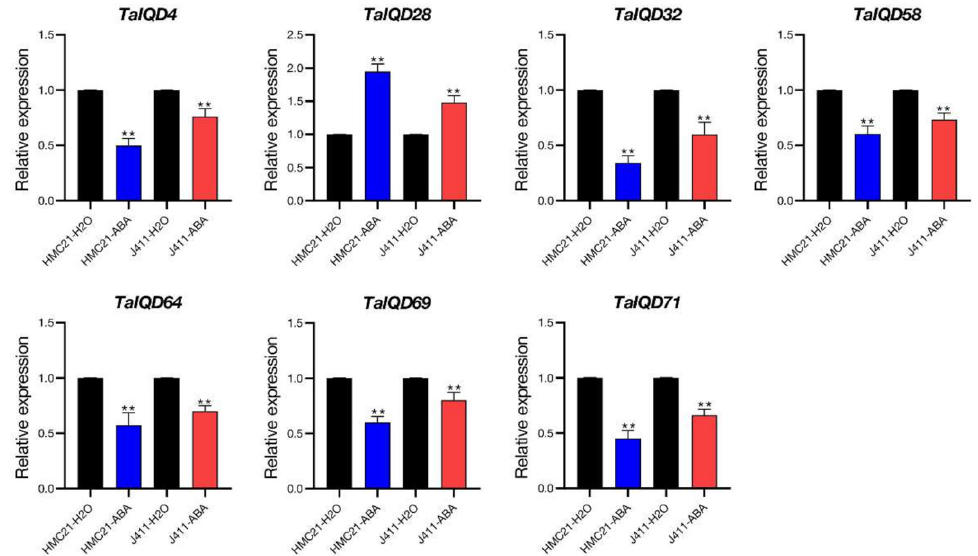
Figure 9. Expression patterns of seven TaIQD genes after 50- µ M ABA treatment in wheat varieties ‘Hongmangchun21’ (HMC21) and ‘Jing411’ (J411). Red indicates weak-dormancy varieties, and blue indicates strong-dormancy varieties. Y axes represent the scales of the relative expression levels. Bars represent the standard deviations (SDs) of three biological replicates. The significance criteria used were ** p <